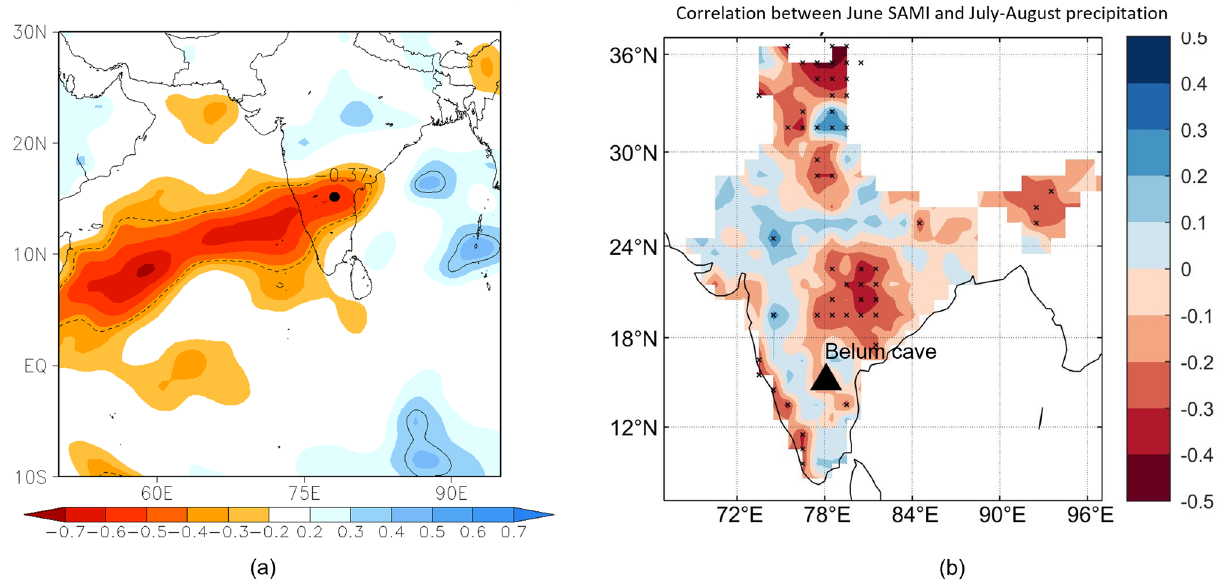
Figure 1. ( a ) Correlation coefficient between IsoGSM model simulated JJAS average rainfall δ 18 O at Belum Cave (Model resolution is ~ 200 × 200 km) and simulated JJAS average rainfall over surrounding grids 15 . Correlation (= − 0.37) with significance level p = 0.05 is marked by black dashed contour. ( b ) Correlation between July–August precipitation and June SAMI (Southern Hemisphere Annular Mode Index) for the period